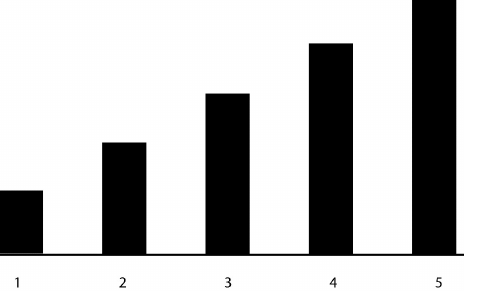
Figure 2. Visualization of the stick scale used for the SSE/French FAS. Figure from Sanchez et al.